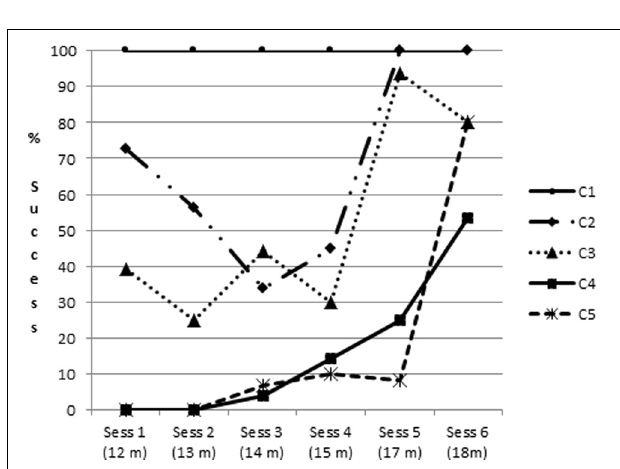
FIGURE 3 | Percentage of success as a function of condition and session (ambiguous successes are